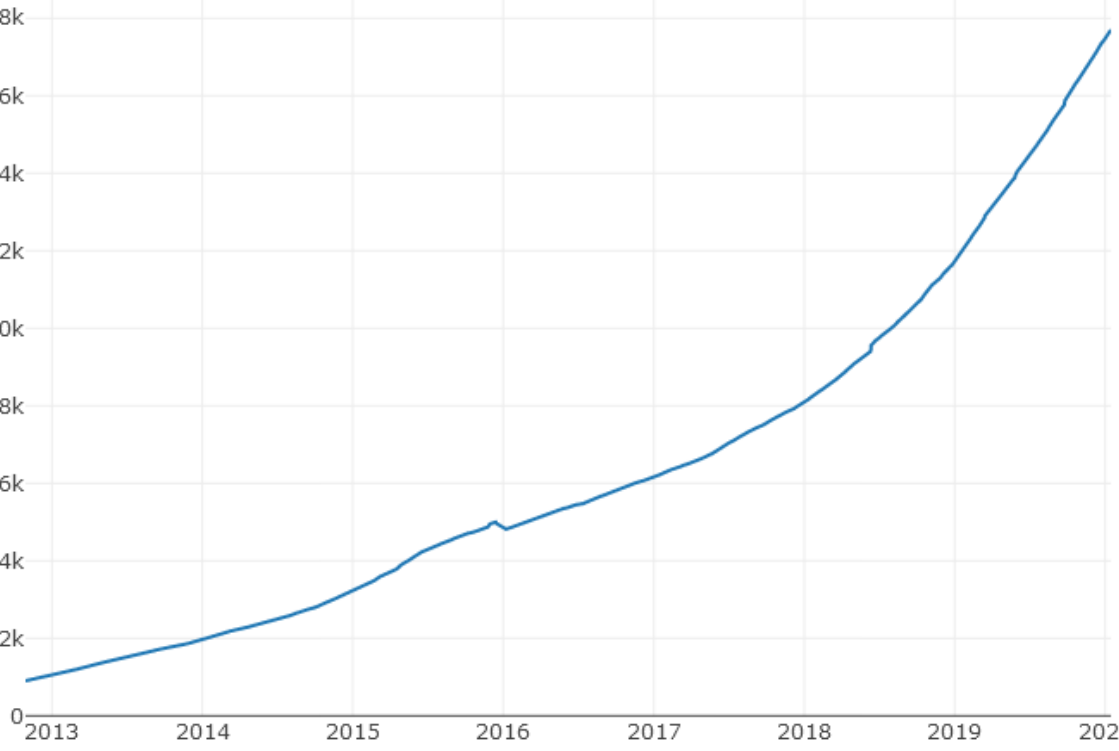
Figure 1. The number of subscribers in the disability subreddit by